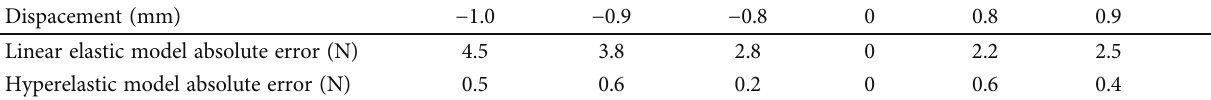
Table 3: Absolute error between calculation and experimental values of two models.